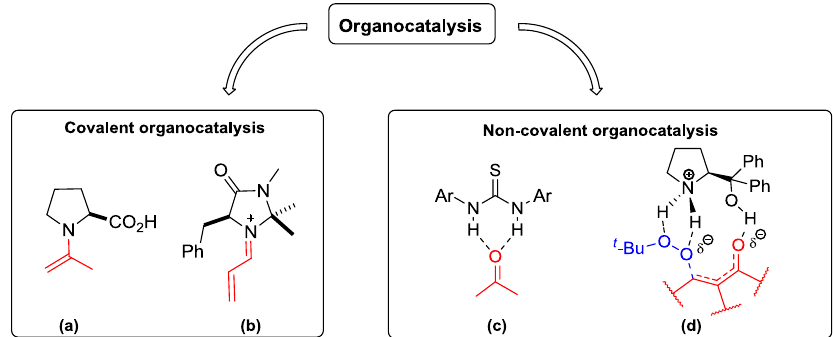
Figure 4. The fi eld of organocatalysis is divided into two main areas, depending on the interactions involved in the mechanism. Some exemplar cases are reported in the Figure. Substrates are red coloured, catalysts are black and in case (d) the oxidant is blue.